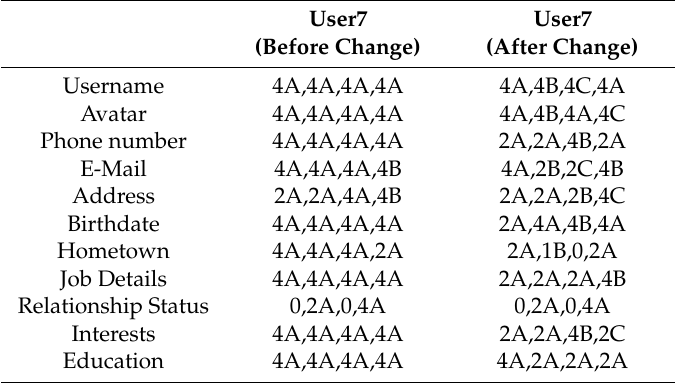
Table 8. Profile change.